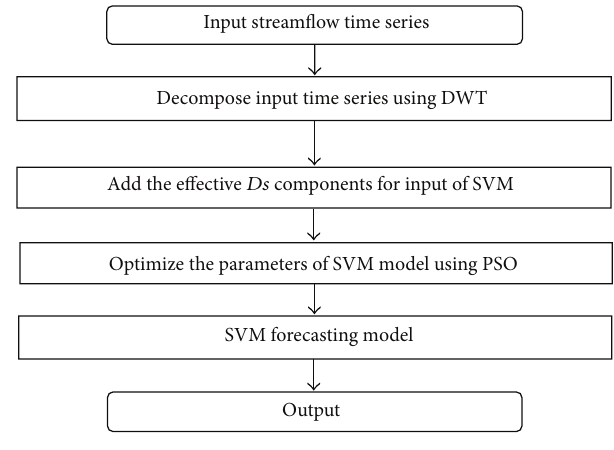
Figure 3: The WA-LSSVM-PSO model structure.